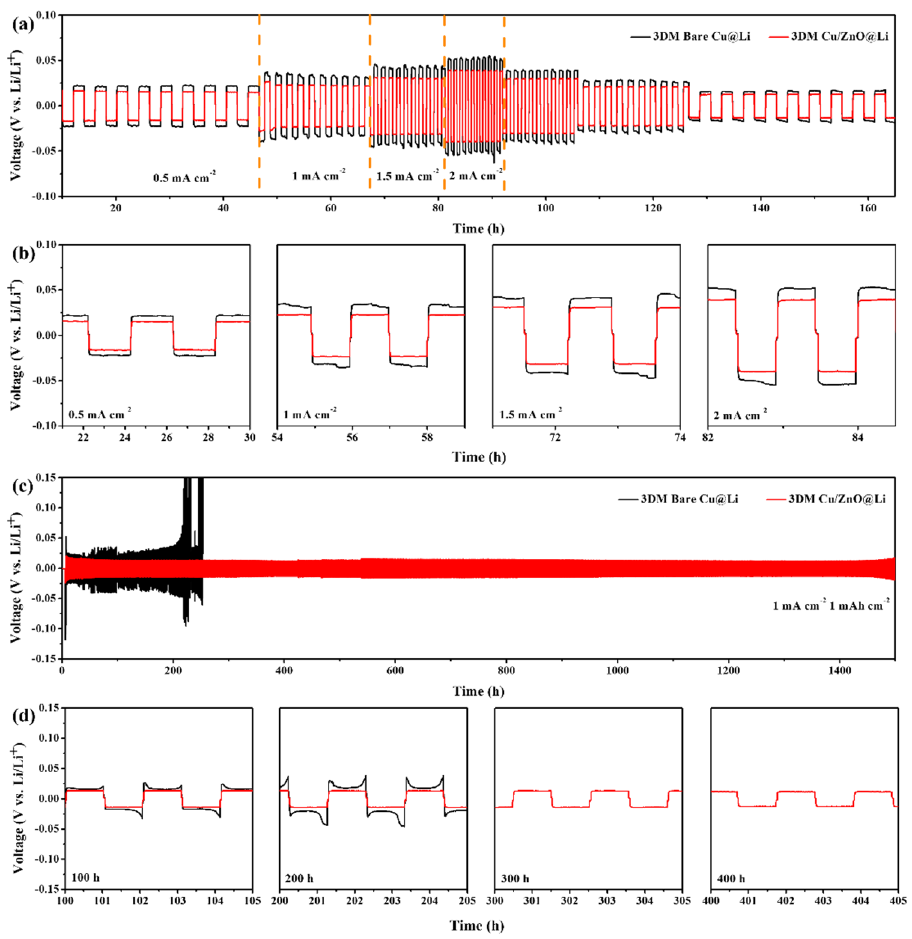
Figure 5. ( a ) Rate performance of 3DM Cu@Li and Cu/ZnO@Li-P composite anode. ( b ) Corre- sponding voltage profiles from ( a ). ( c ) Cycle performance of 3DM Bare Cu@Li and Cu/ZnO@Li-P composite anode at 1 mA cm − 2 and 1 mAh cm − 2 . ( d ) Voltage profiles of the 100, 200, 300, and 400 h cycles from ( c